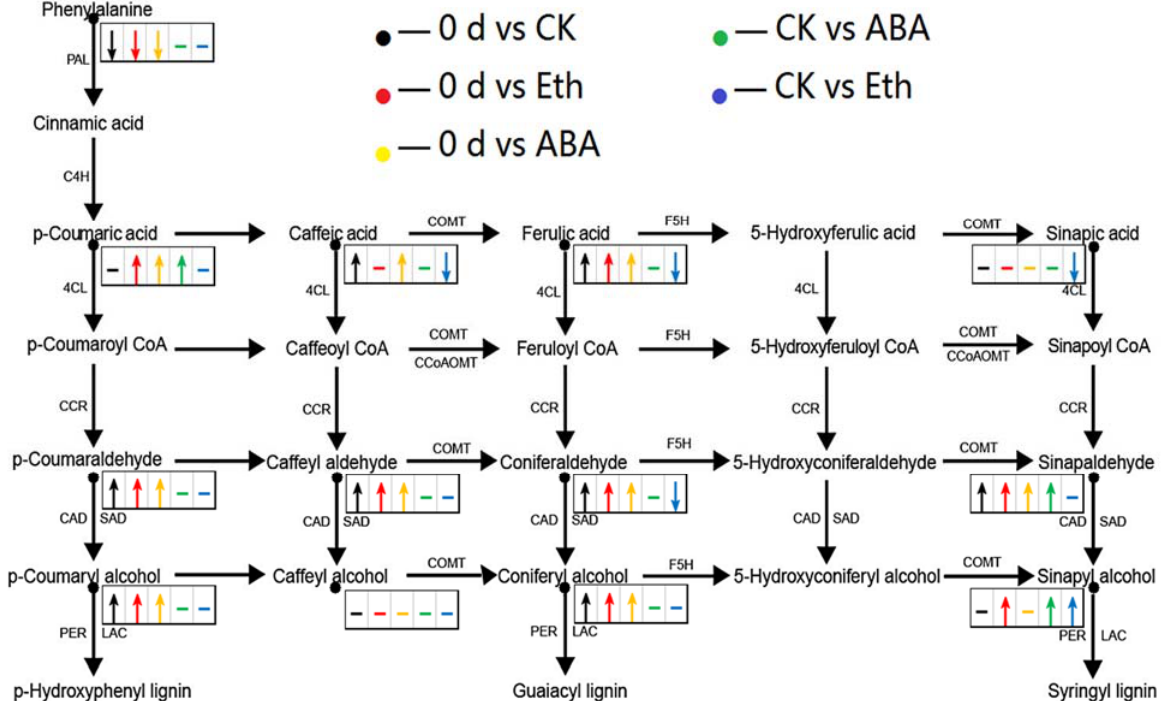
Figure 5. Contents and changes in lignins in fresh-cut carrot in various treatments. ↓ : the metabolite content was significantly down; − : the metabolite content had no significant change; and ↑ : the metabolite content was significantly up.